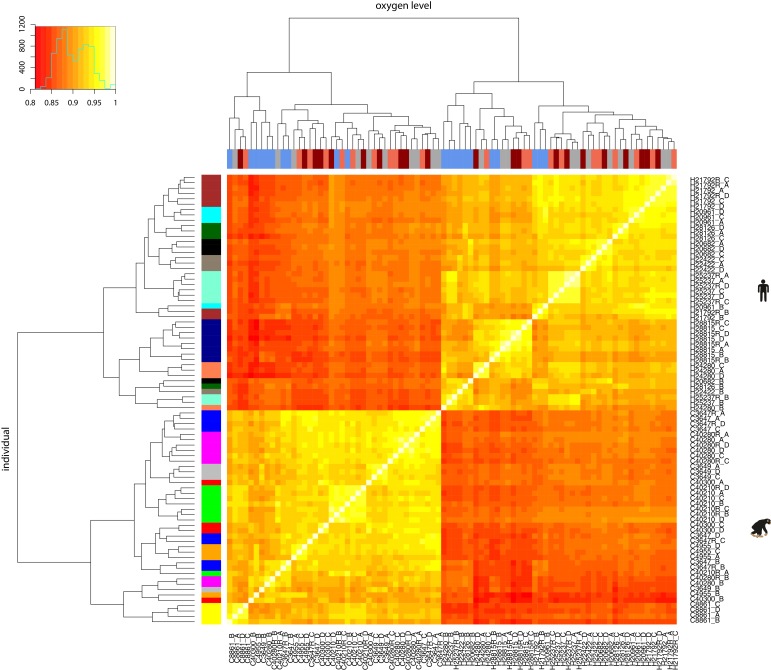
RNA-seq samples cluster by species and then by oxygen level or individual.Spearman correlation of between-sample RUVs-normalised log2cpm values. X-axis bar represents the oxygen level: brown: 10% oxygen baseline (A), blue: 6 hr after 1% oxygen (B), coral: 6 hr of re-oxygenation at 10% oxygen after hypoxia (C), dark red: 24 hr of re-oxygenation at 10% oxygen after hypoxia (D). Y-axis bar represents the individual: each colour represents the individual from which the samples came. There are four samples per individual except for the six individuals with replicates, which have eight samples.